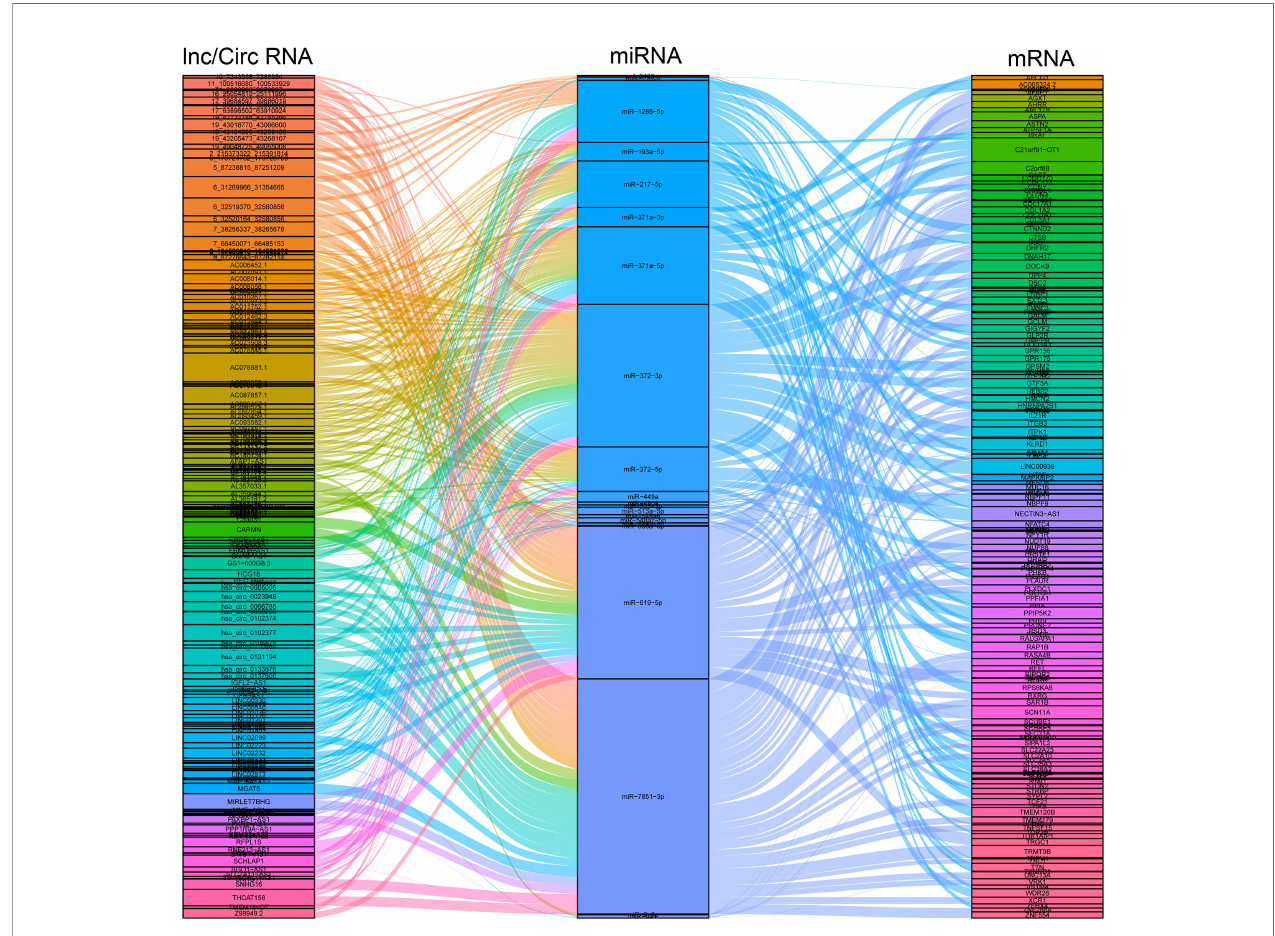
FIGURE 3 | Construction of the circ/lncRNA-miRNA-mRNA ceRNA regulatory network. The ceRNA regulatory network included 21DEmiRNAs, 36 DEcircRNAs, 146 DElncRNAs, and 169 DEmRNAs. ceRNA, competing endogenous RNA; circRNAs, circular RNAs; miRNAs, microRNAs; DE, differentially